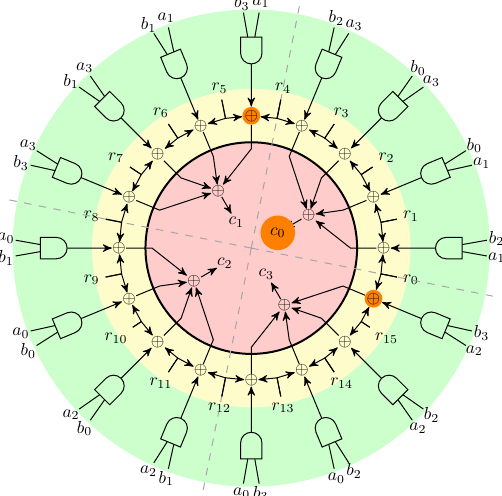
Figure 12: The robust-3-probing secure CMS scheme found with our formalization. Highlighted in orange the probes which make the above scheme not